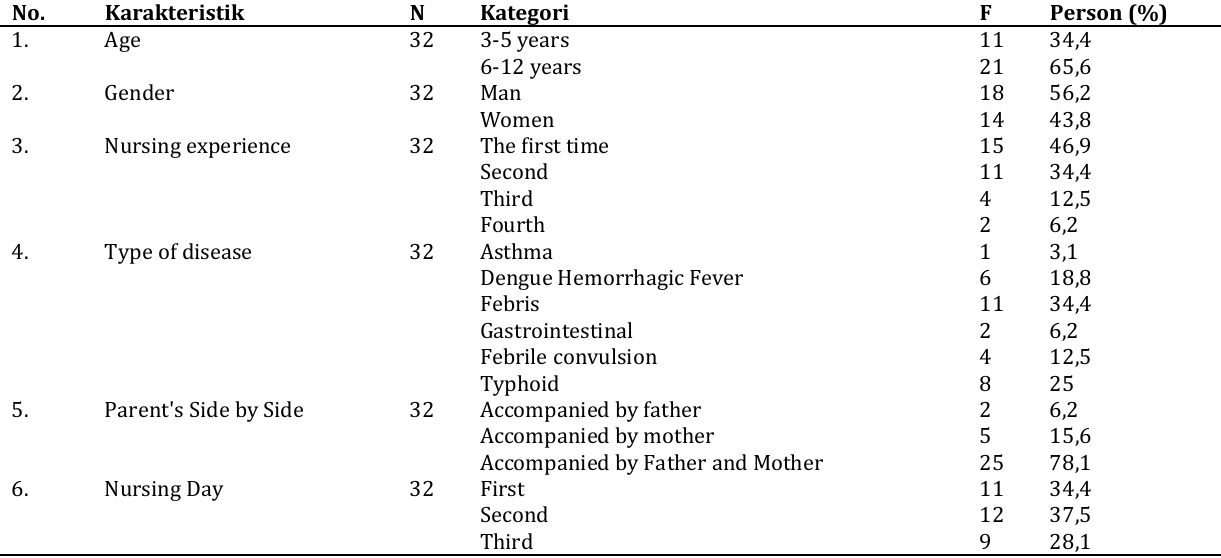
Table. 1. Distribution of Respondents Based on the Characteristics of Children of the Age 3-12 years who were given Intravenous Therapy in the Children's Room of Ratu Zalecha Martapura Hospital in 2015. No.